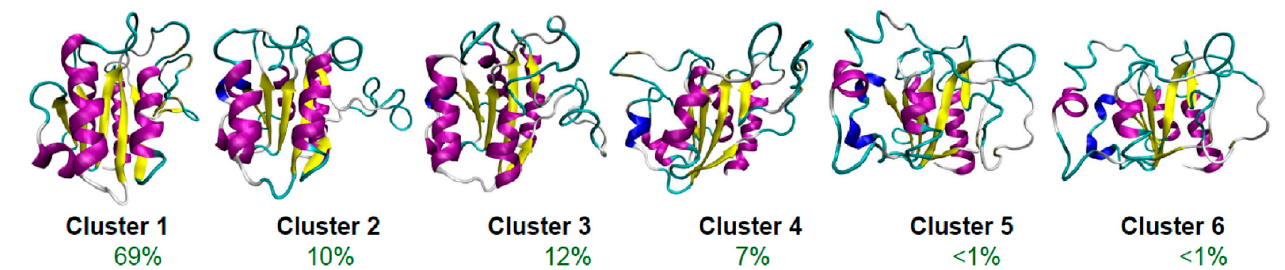
Figure 1. Early intermediates in the thermal unfolding of apoflavodoxin. The percentage of popu- lation of these clusters is displayed. Modified from García-Fandiño R, Bernadó P, Ayuso-Tejedor S, Sancho J, Orozco M (2012) Defining the Nature of Thermal Intermediate in 3 State Folding Proteins: Apoflavodoxin, a Study Case. PLoS Comput Biol 8(8): e1002647 [298] , which is an open-